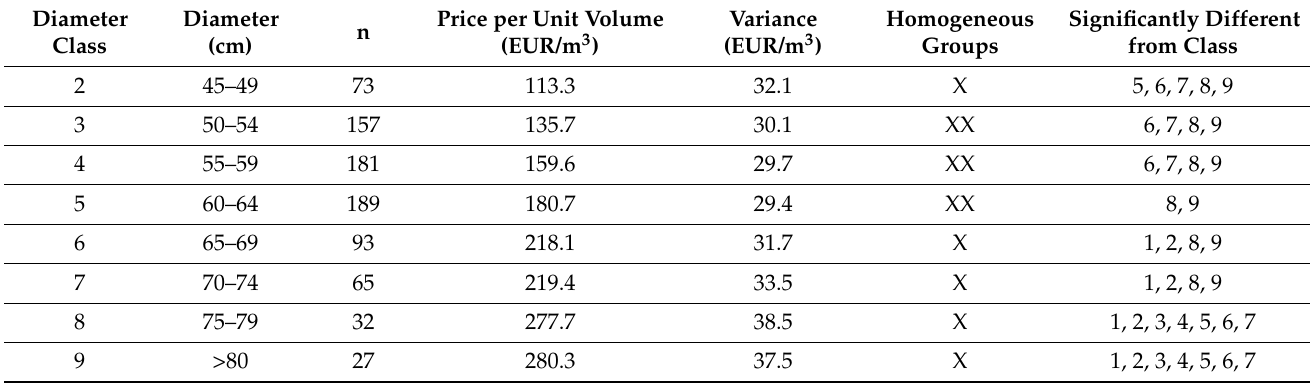
Table 4. Dependence of the price per cubic metre and diameter class of the spruce logs (Duncan, p < 0.05).